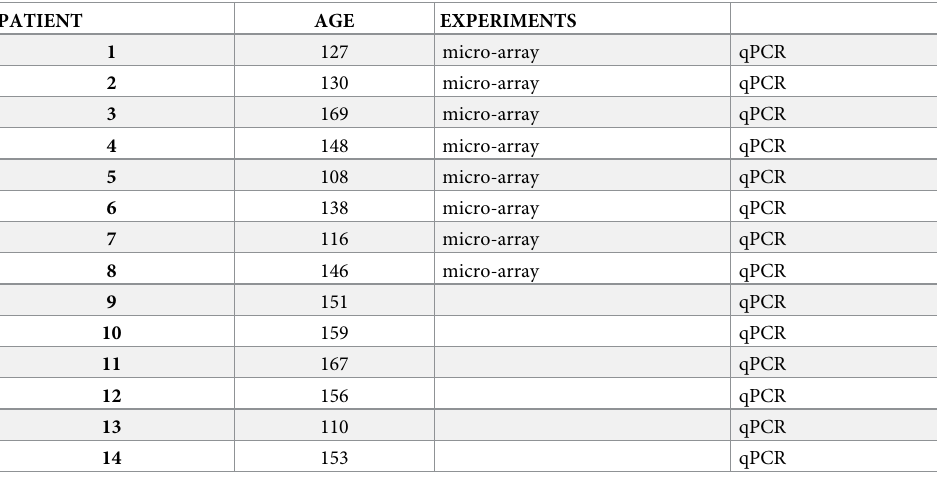
Table 1. Matrial used for micro-array and qPCR gene expression profiling.